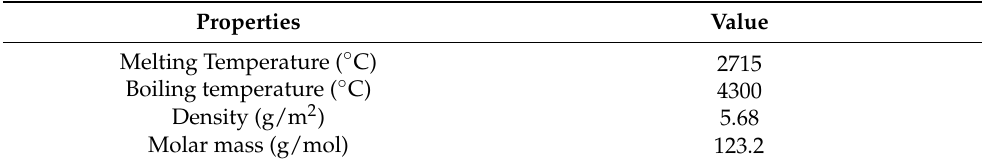
Table 9. Zirconia properties